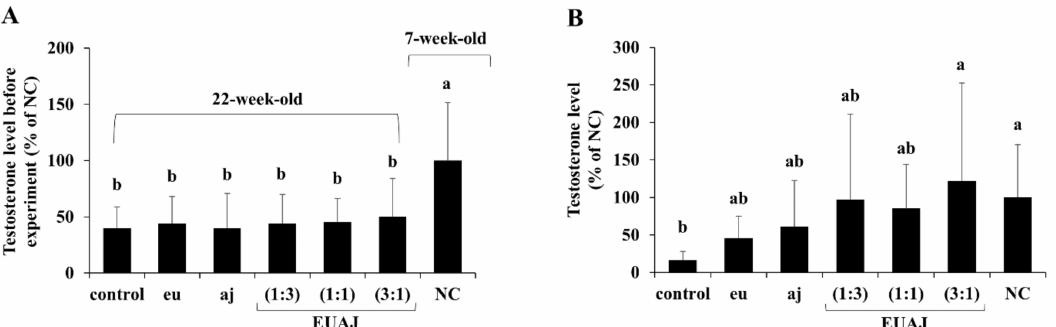
Figure 1. The Effects of EUAJ on testosterone levels in serum of SD rats. Serum testosterone levels of SD rats administered by eu, aj and its combinations in various proportions were shown in ( A ) and ( B ). Values are presented as means ± SD. Different superscript letters show a significantly difference at p < 0.05 as determined by Duncan’s multiple range test. Control; saline, aj:aj (40 mg/kg), eu:eu (40 mg/kg), EUAJ (1:3); eu:aj = 1:3 (40 mg/kg), EUAJ (1:1); eu:aj = 1:1 (40 mg/kg), EUAJ (3:1); eu:aj = 3:1 (40